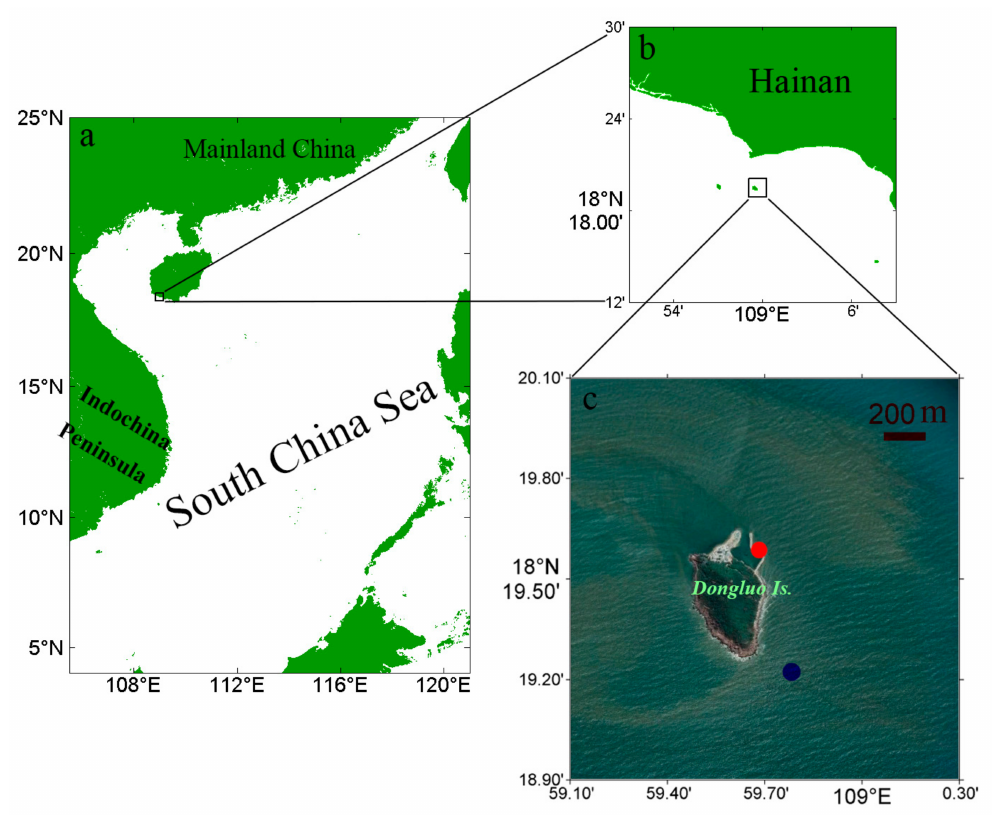
Figure 1. The geolocation of Dongluo Island in the SCS (( a ) the area in the black box is zoomed-in) ( b ), relative to the Hainan coast (the area in the black box is zoomed-in), ( c ) and the hydro- meteorological monitoring station of the island (the red and blue dots are the meteorological and hydrological stations, respectively). The distance between the meteorological and hydrological stations is about 700